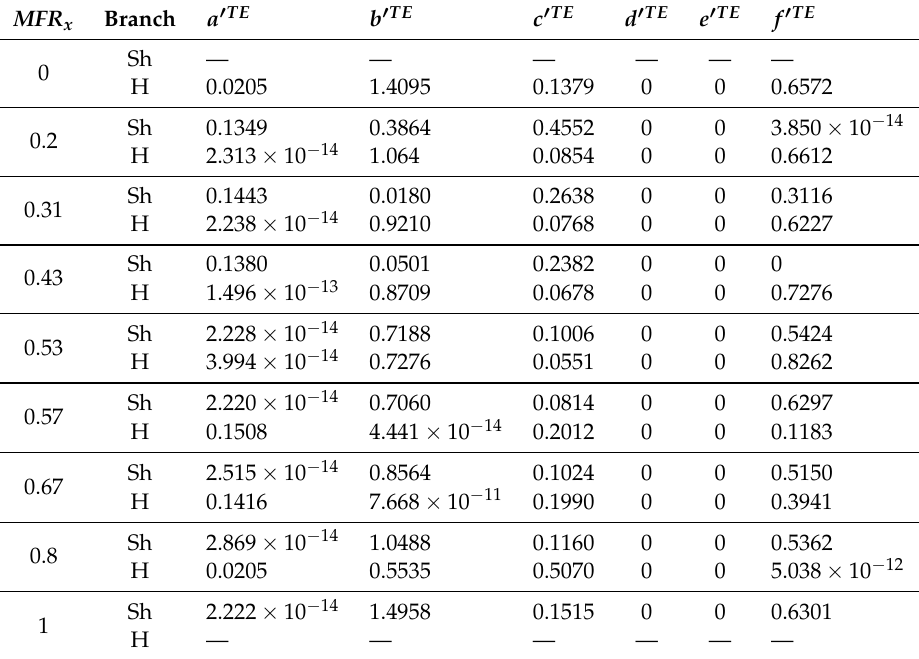
Table 3. Apparent efficiency fitting coefficients from Equation (25) for each turbine branch of T#1TE [12]. Every MFR map is fitted